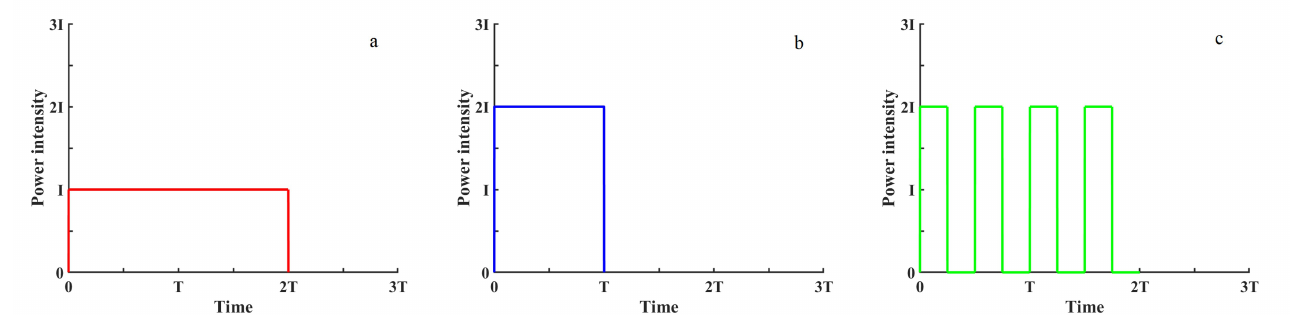
Figure 2. The different shapes of light in the same dose. Continuous wave light ( a ): P L = 1, t = 2, D c = 1; ( b ): P L = 2, t = 1, D c = 1 and pulsed light ( c ): P L = 2, t = 2, D c =